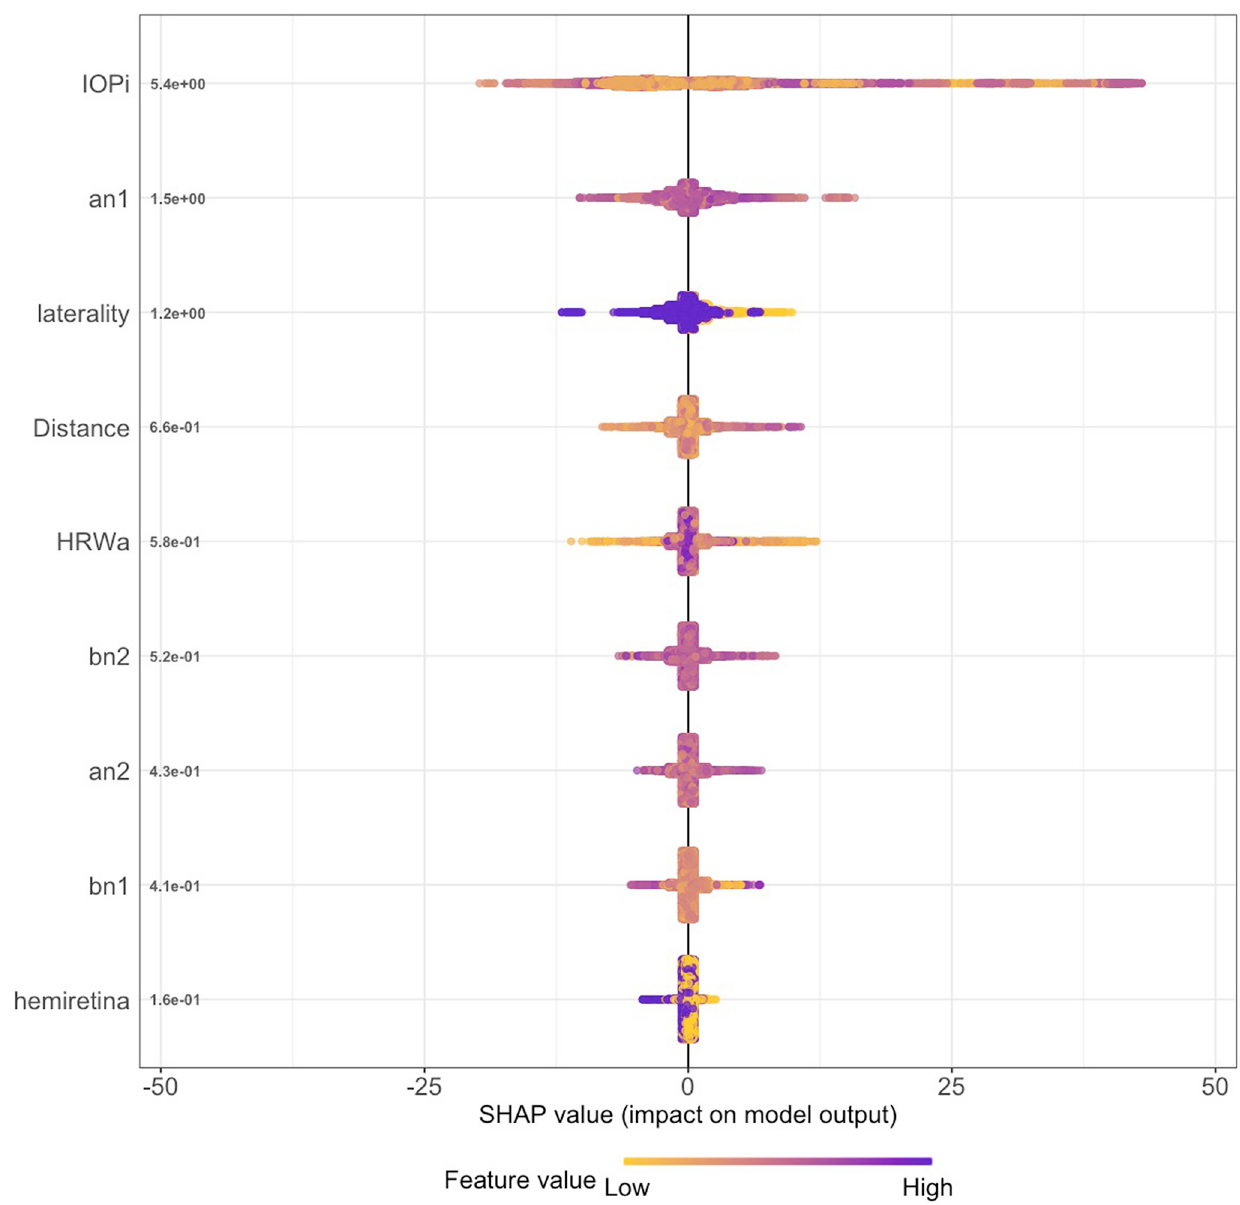
Fig 9. SHAP summary plot retinal arterial model demonstrating the feature contribution of the XGB model predicting ICP from the arterial model. Induced intraocular pressure (IOP i ) was the most important feature in the model (mean SHAP = 5.3884), approximately four times the value of the cosine coefficient of the first harmonic (a n1 mean = 1.4689). Laterality = Right/Left eye, Distance = Retinal vascular pulsation amplitude as a function of distance from the center of the optic disc in mm, HRW a =Harmonic regression wave amplitude, a n1,2 , b n1,2 =cosine and sine coefficients of the first and second harmonics, hemiretina = Superior/Inferior retina.